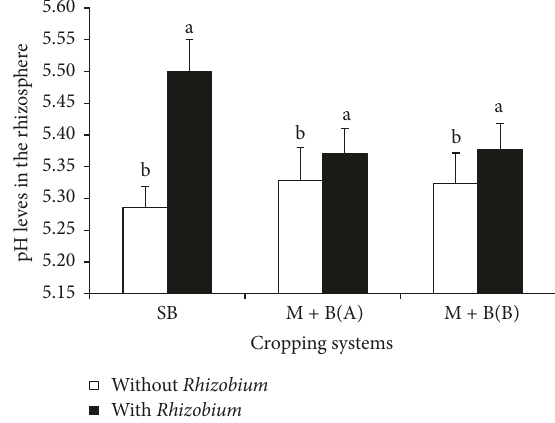
Figure 2: Interactive effect of cropping systems and Rhizobium inoculation on rhizosphere soil pH. SB: sole soybean; M + B (A): maize/soybean intercropped at a spacing of 75 × 60 cm and 75 × 20 cm, maize, and soybean, respectively; M + B (B): maize/soybean intercropped at a spacing of 75 × 60 cm and 75 × 40 cm, maize, and soybean,